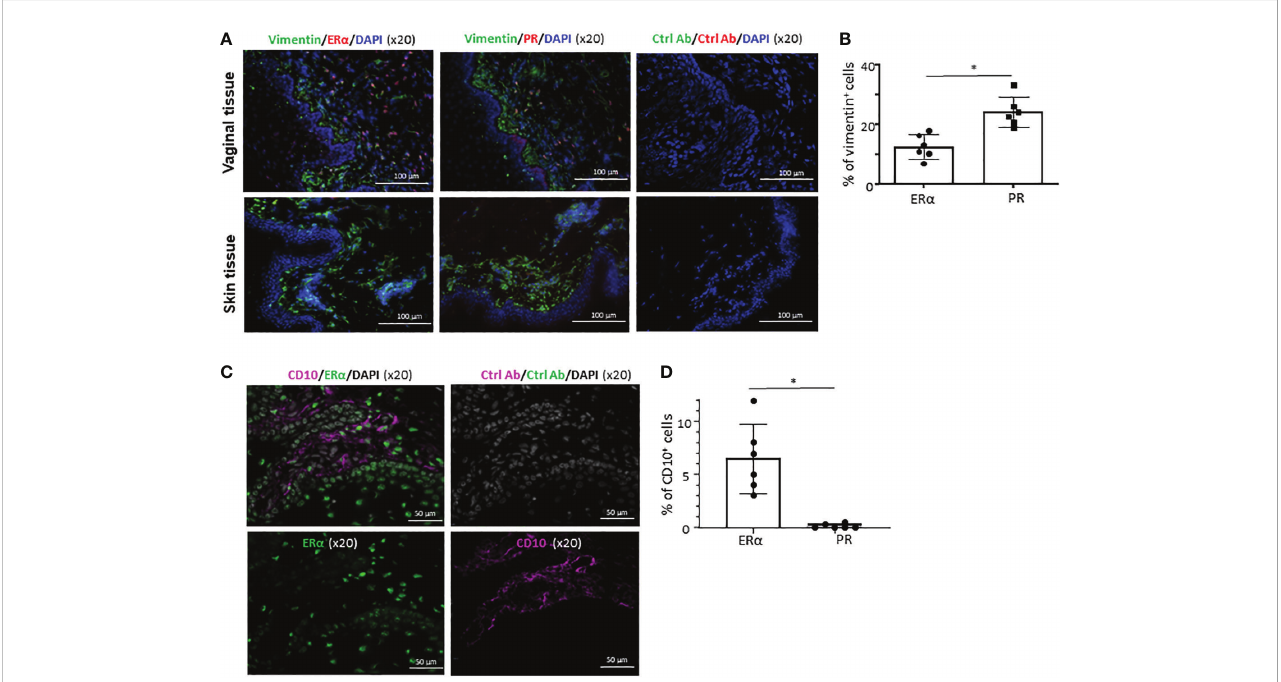
FIGURE 4 Cell type- and tissue-speci fi c expression of ER a and PR. (A) Frozen sections of the VM tissues (upper panels) and abdominal skin tissues (lower panels) were stained with anti-vimentin antibody along with anti-ER a or anti-PR antibody (x10). Tissue sections were also stained with isotype control antibodies. Ages of VM and skin tissue donors were 33 and 38 year-old, respectively. Data generated with VM tissue from 3 other donors (49, 59, and 62-year-old) and skin tissues from 2 other donors (48 and 58-year-old) showed similar results. (B) Data (mean ± SD) from two independent experiments using tissues from 6 donors (33, 43, 60, 68, 71, and 72-year-old) are presented. (C) Frozen sections of the VM tissues (from 43-year-old) were stained with anti-CD10 along with anti-ER a or anti-PR antibody (x20). Tissue sections were also stained with isotype control antibodies. VM tissues of two other donors (37 and 69-year-old) showed similar results. (D) Data (mean ± SD) from three independent experiments using tissues from 6 donors (29, 49, 51, 59, 63, 68-year- old) are presented. Statistical signi fi cance was determined with a paired t-test. *p <